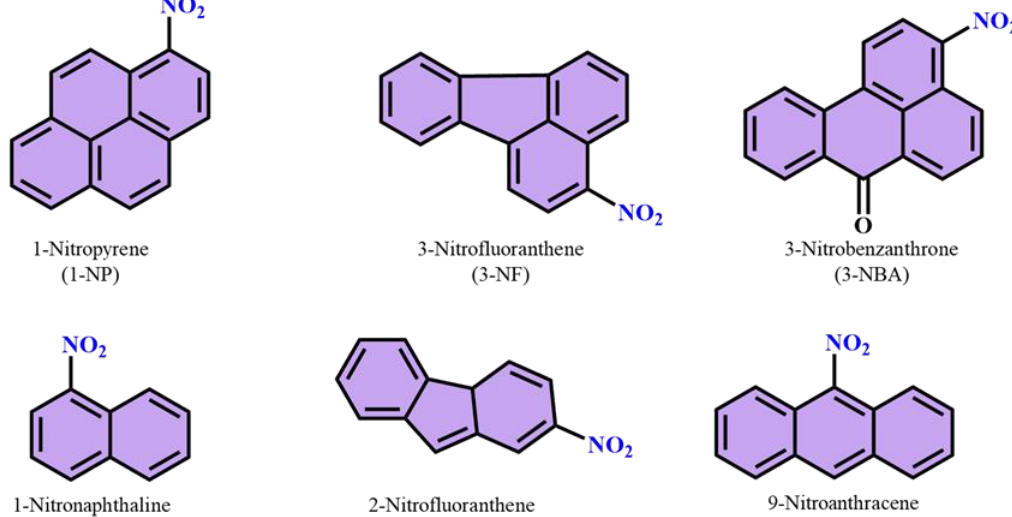
Figure 13. Chemical structures of nitro group containing polyaromatic hydrocarbons (nitro PAHs).